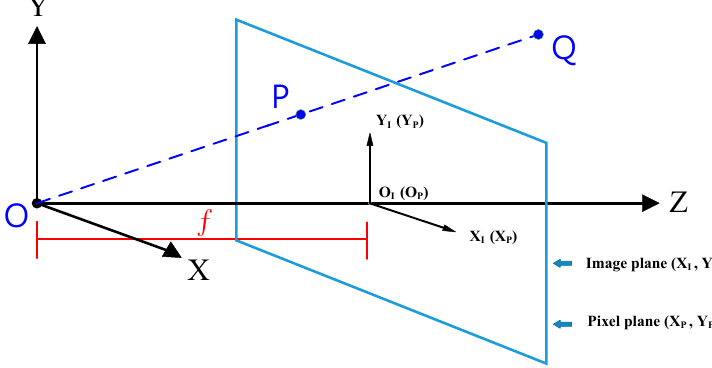
Figure 5. Image projection in relation to the coordinates.